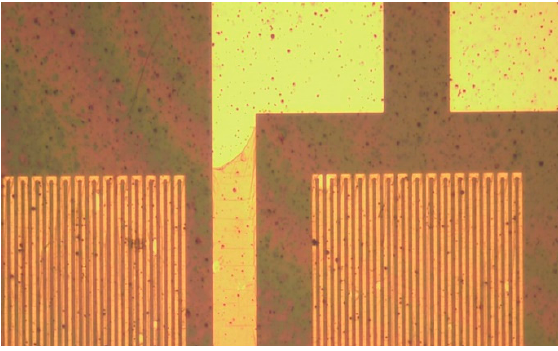
Figure 7. Completed flexible microsensor sensing structure.